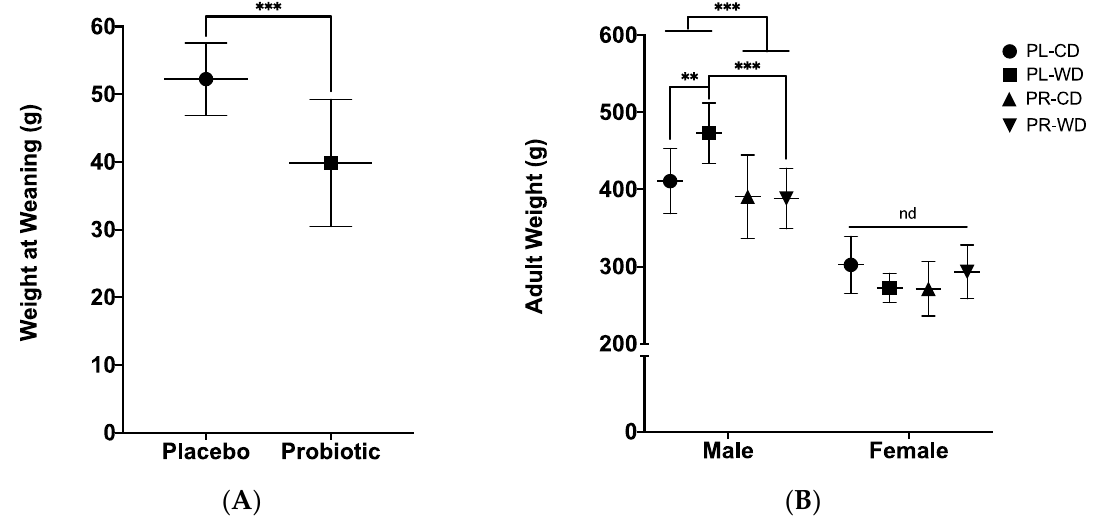
Figure 4. ( A ) Wean weight in placebo and probiotic animals; ( B ) Adult weight in all animals at an average of 67 days old. Data expressed as M ( SD ). ** p < 0.01, *** p < 0.001, nd: no difference. PL: placebo; PR: probiotic; WD: Western diet; CD: control diet.